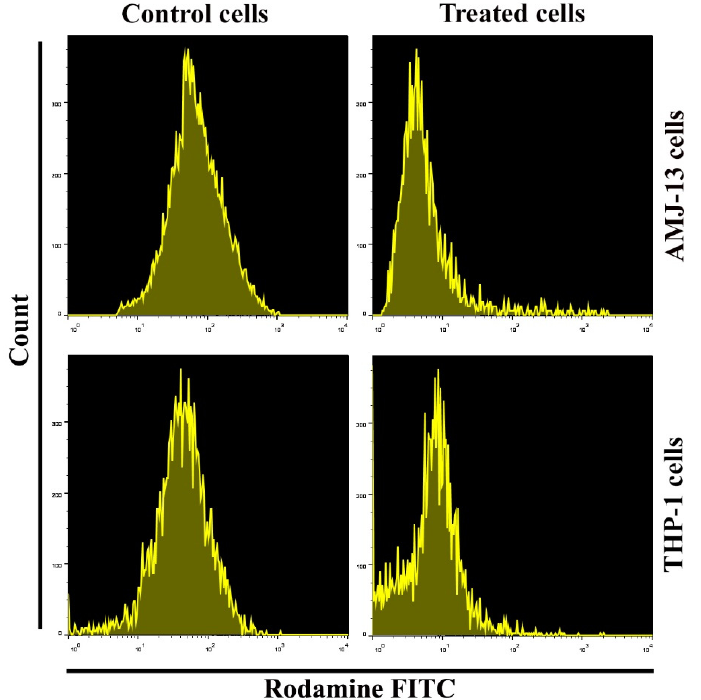
Figure 5. AgNPs induce apoptosis in AMJ-13 and THP-1 cells. Cells were exposed to AgNPs at IC 50 (17.34 µ gmL − 1 ) for 24 h then stained with propidium iodide (PI). Sub-G 1 phase of cells, flow cytometry data of AMJ-13 and THP-1 cells.